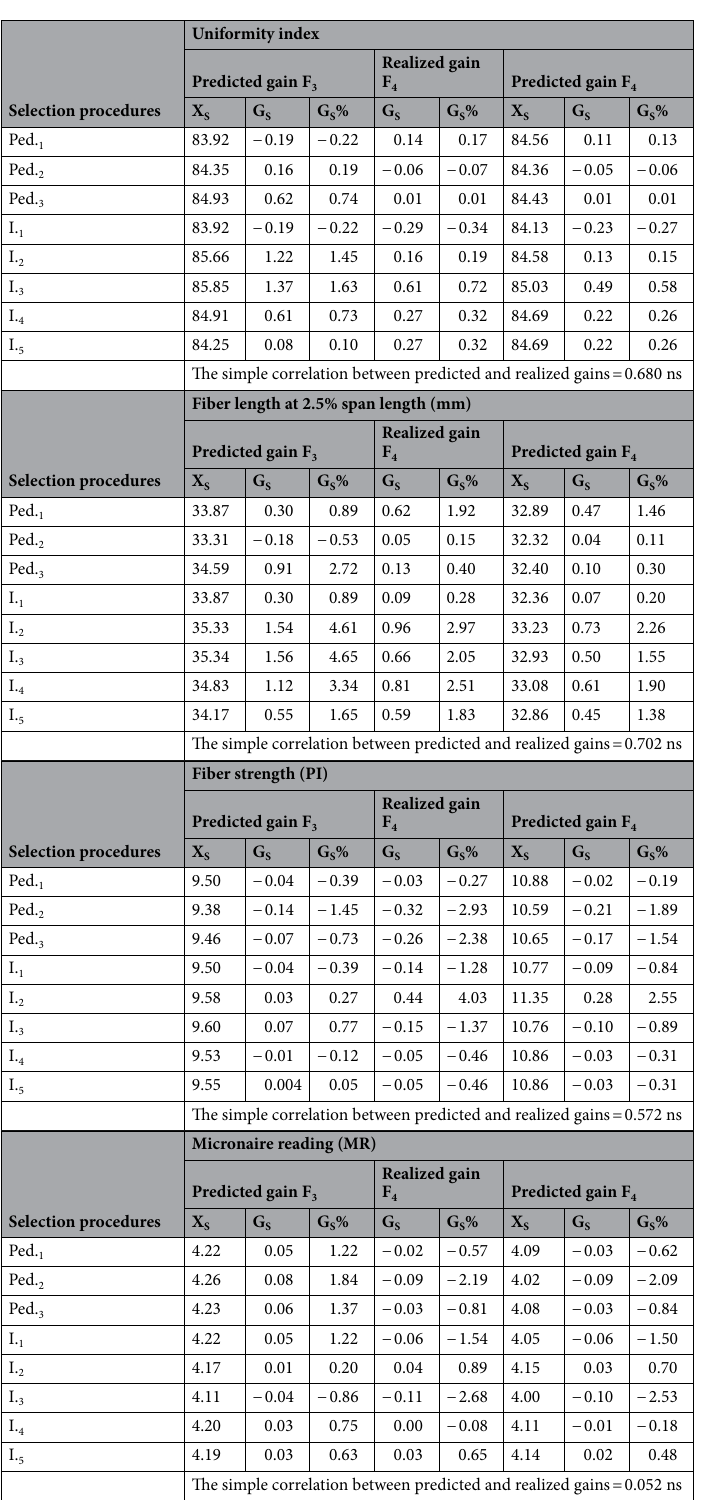
Table 4. Predicted and realized gains from the different selection procedures for fiber properties in the three segregating generations. Ped. 1 = Direct selection for lint cotton yield/plant, Ped.2 = Direct selection for lint percentage, Ped.3 = Direct selection for lint index, I. 1 = Selection index involving yield and its components, I. 2 = Selection index involving boll weight, seeds per boll, seed index, fiber length, and Pressley index, I. 3 = Selection index involving lint percentage, lint index, fiber length and uniformity index, I. 4 = Selection index involving all characters Smith, (1936)., I. 5 = Selection index involving all characters 50